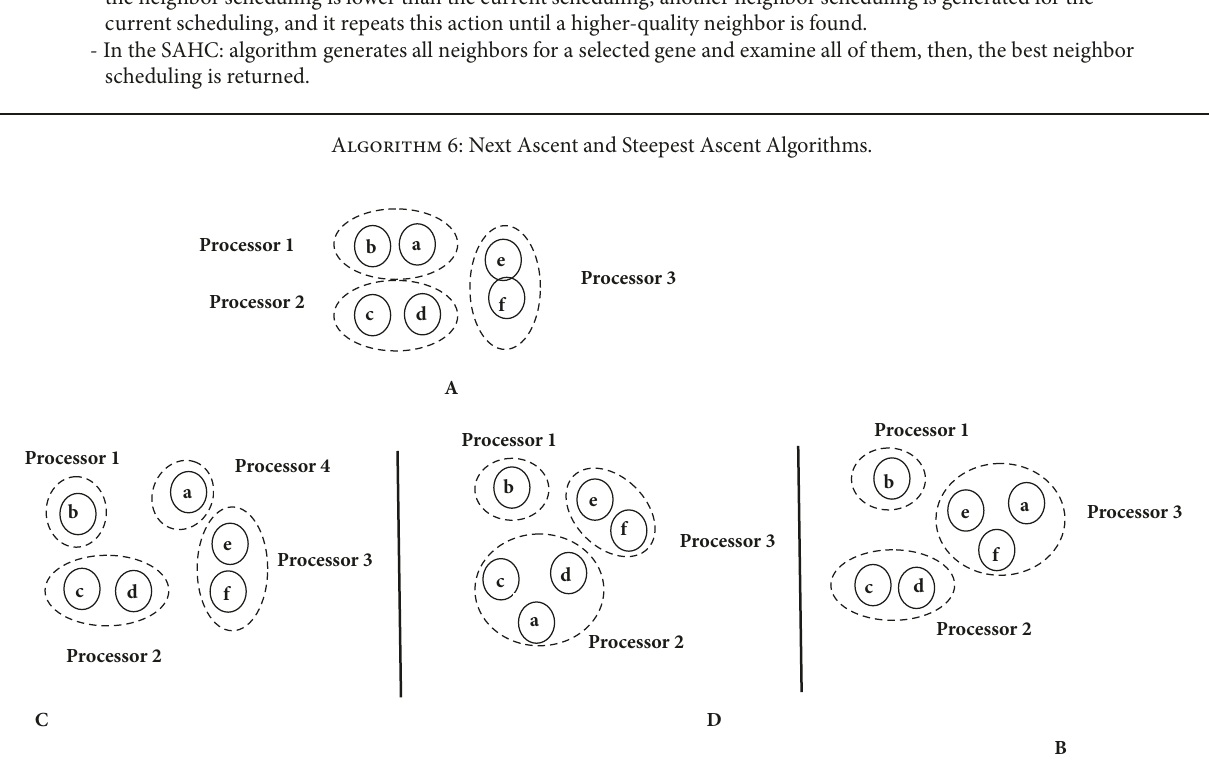
Figure 5: Neighborhood for task